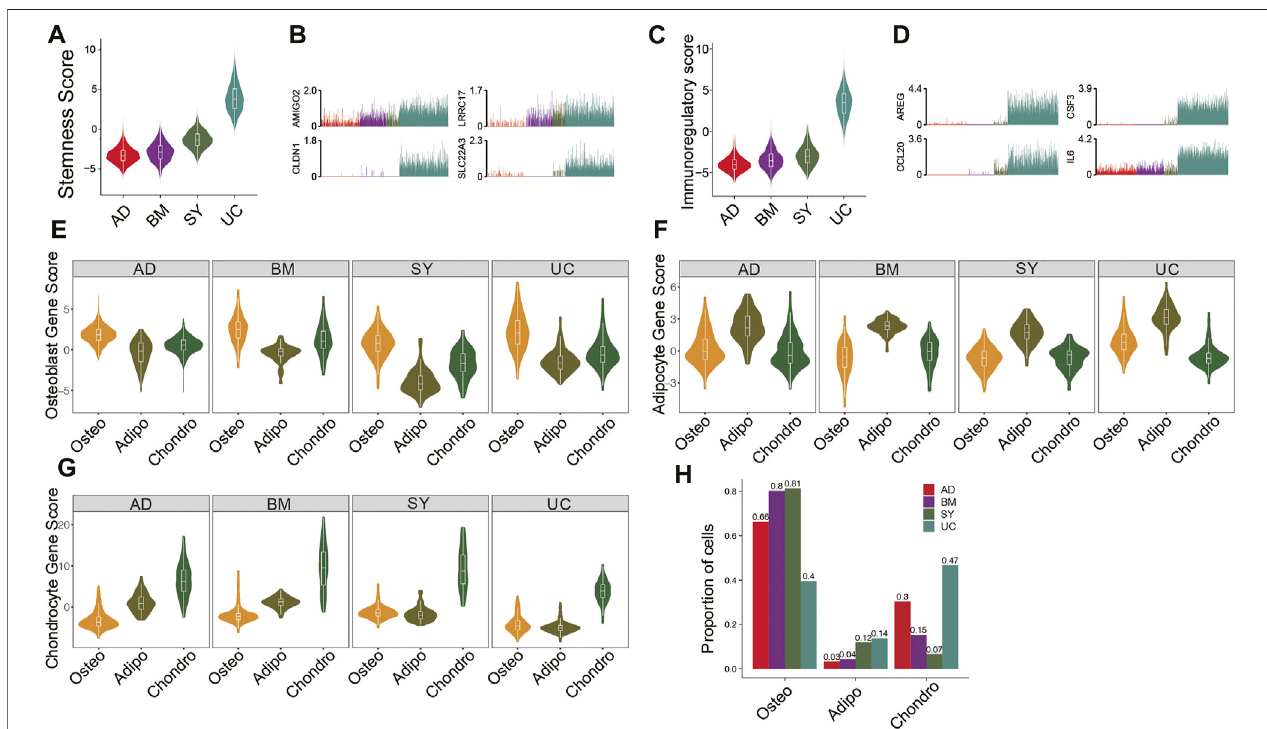
FIGURE 2 | Features and lineage-speci fi c differentiation potentials of MSC subpopulations. (A) . Violin plot of stemness scores of MSCs in 4 different tissues. (B) . Bar plot of the expression level of AMIGO2, CLDN1, LRRC17, and SLC22A3 in each cell. (C) . Violin plot of immunoregulatory scores of MSCs in 4 different tissues. (D) . Barplotoftheexpressionlevelof AREG,CSF3,CCL20, and IL6 ineachcell. (E – G) .Violinplotofosteocytescore. (E) ,adipocytescore. (F) ,andchondrocytescore. (G) of MSCs in MSC subpopulations. (H) . Fractions of MSC subpopulations in MSCs for each tissue.